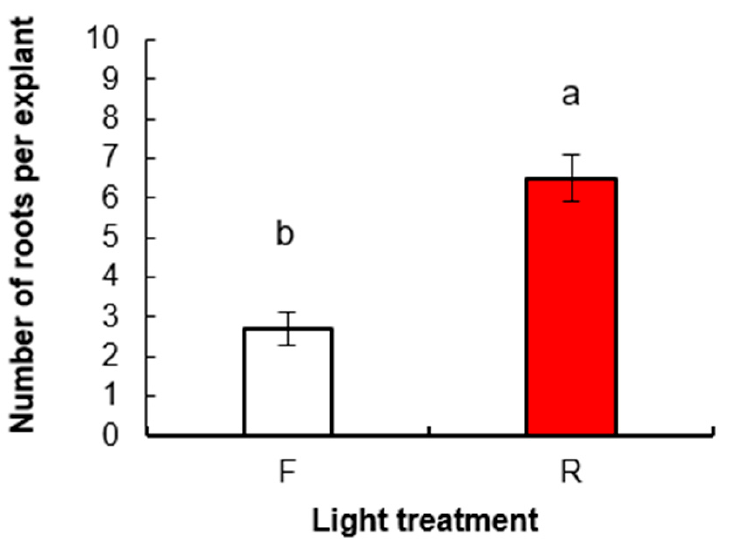
Figure 5. Number of roots per explant in shoots of Cryptomeria japonica cultured in QL medium [15], supplemented with 3% ( w/v ) sucrose or 1.5% ( w/v ) sucrose under light treatments (fluorescent light (F) and red LEDs (R)). Data are presented as mean values ± S.E. Significant differences are indicated by different letters according to Tukey’s post hoc test ( p < 0.05).